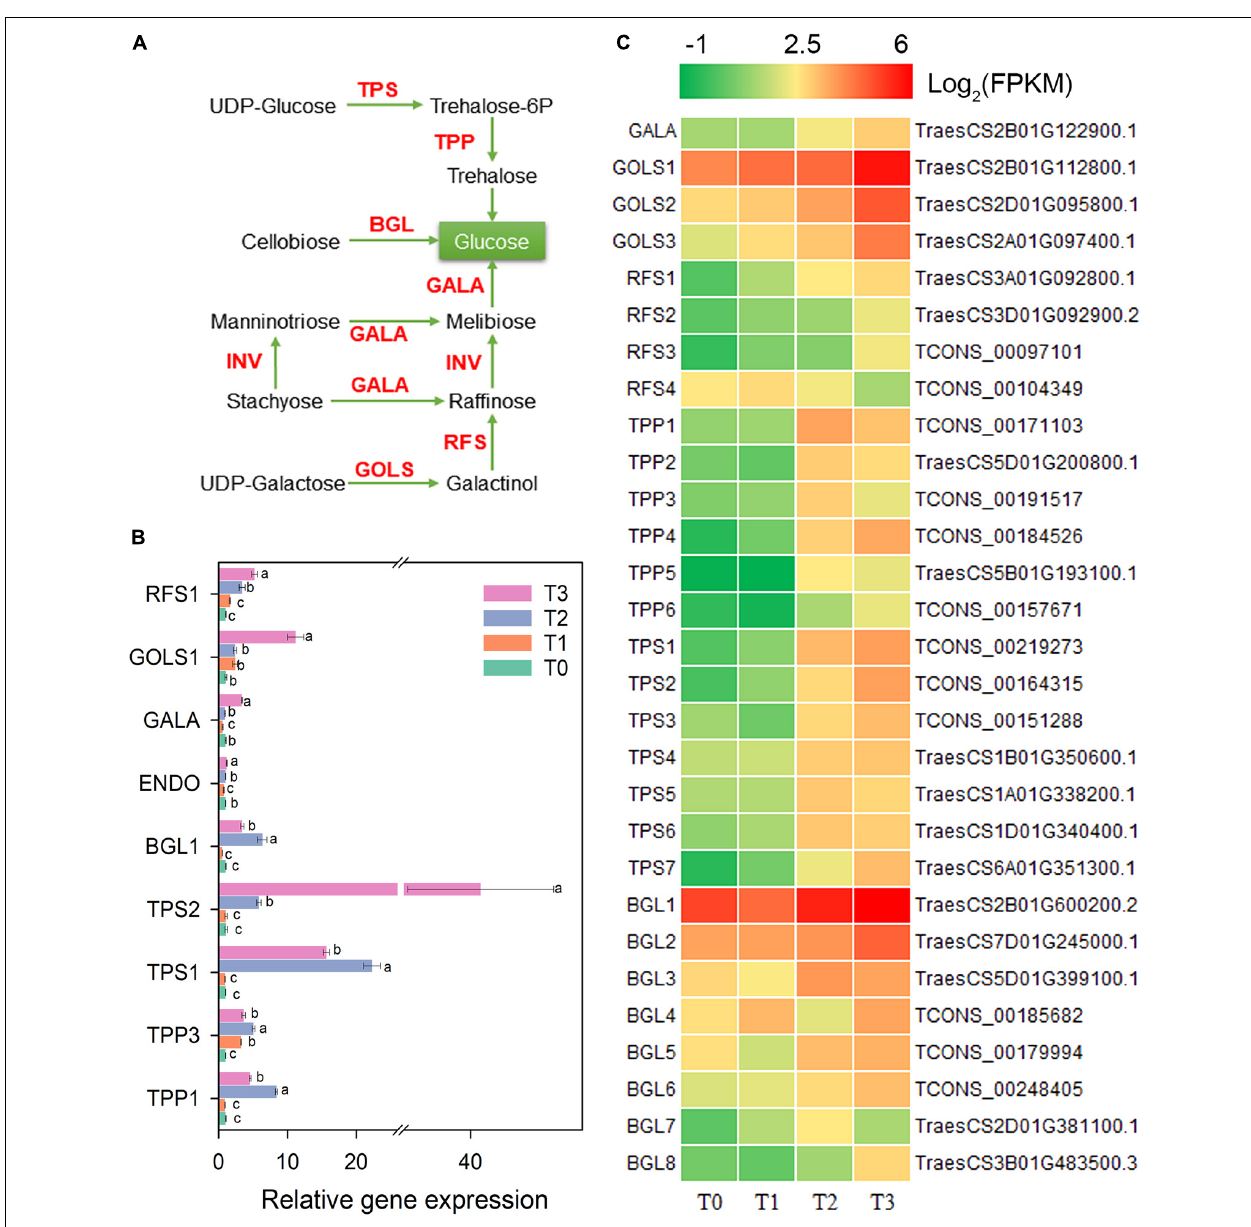
FIGURE 6 | Genes involved in the metabolism of trehalose, cellulose, melibiose, raffinose, and galactose. GALA, α -galactosidase; GOLS, inositol 3- α -galactosyltransferase; RFS, raffinose synthase; TPP, trehalose-6-phosphate phosphatase; TPS, trehalose-6-phosphate synthase; BGL, β -glucosidase. (A) Pathway map of trehalose, cellulose, melibiose, raffinose, and galactose. (B) Verification of the expression of some genes in the pathway. Data are the mean values of four independent replicates ( n = 4), and error bars show the standard error. Duncan’s multiple-comparison test was used for ANOVA, and different lowercase letters indicate a significant difference at the level of P < 0.05. (C) Heatmap of differentially expressed mRNAs in this pathway. T0, T1, T2, and T3 means the sample was harvested at 0, 2, 24, and 72 h after mowing, respectively.